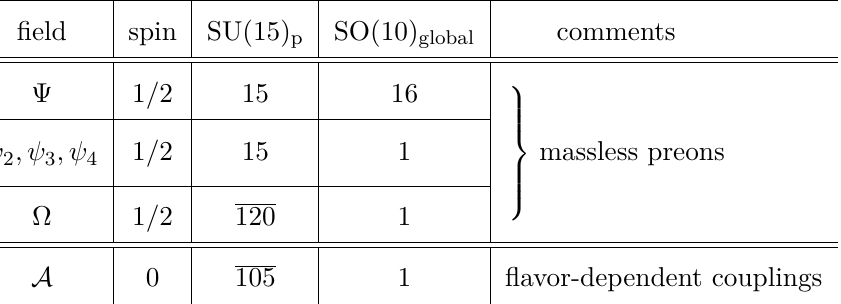
Table 1 . Fields charged under the SU(15) p gauge group. The global SO(10) symmetry embeds the SM gauge